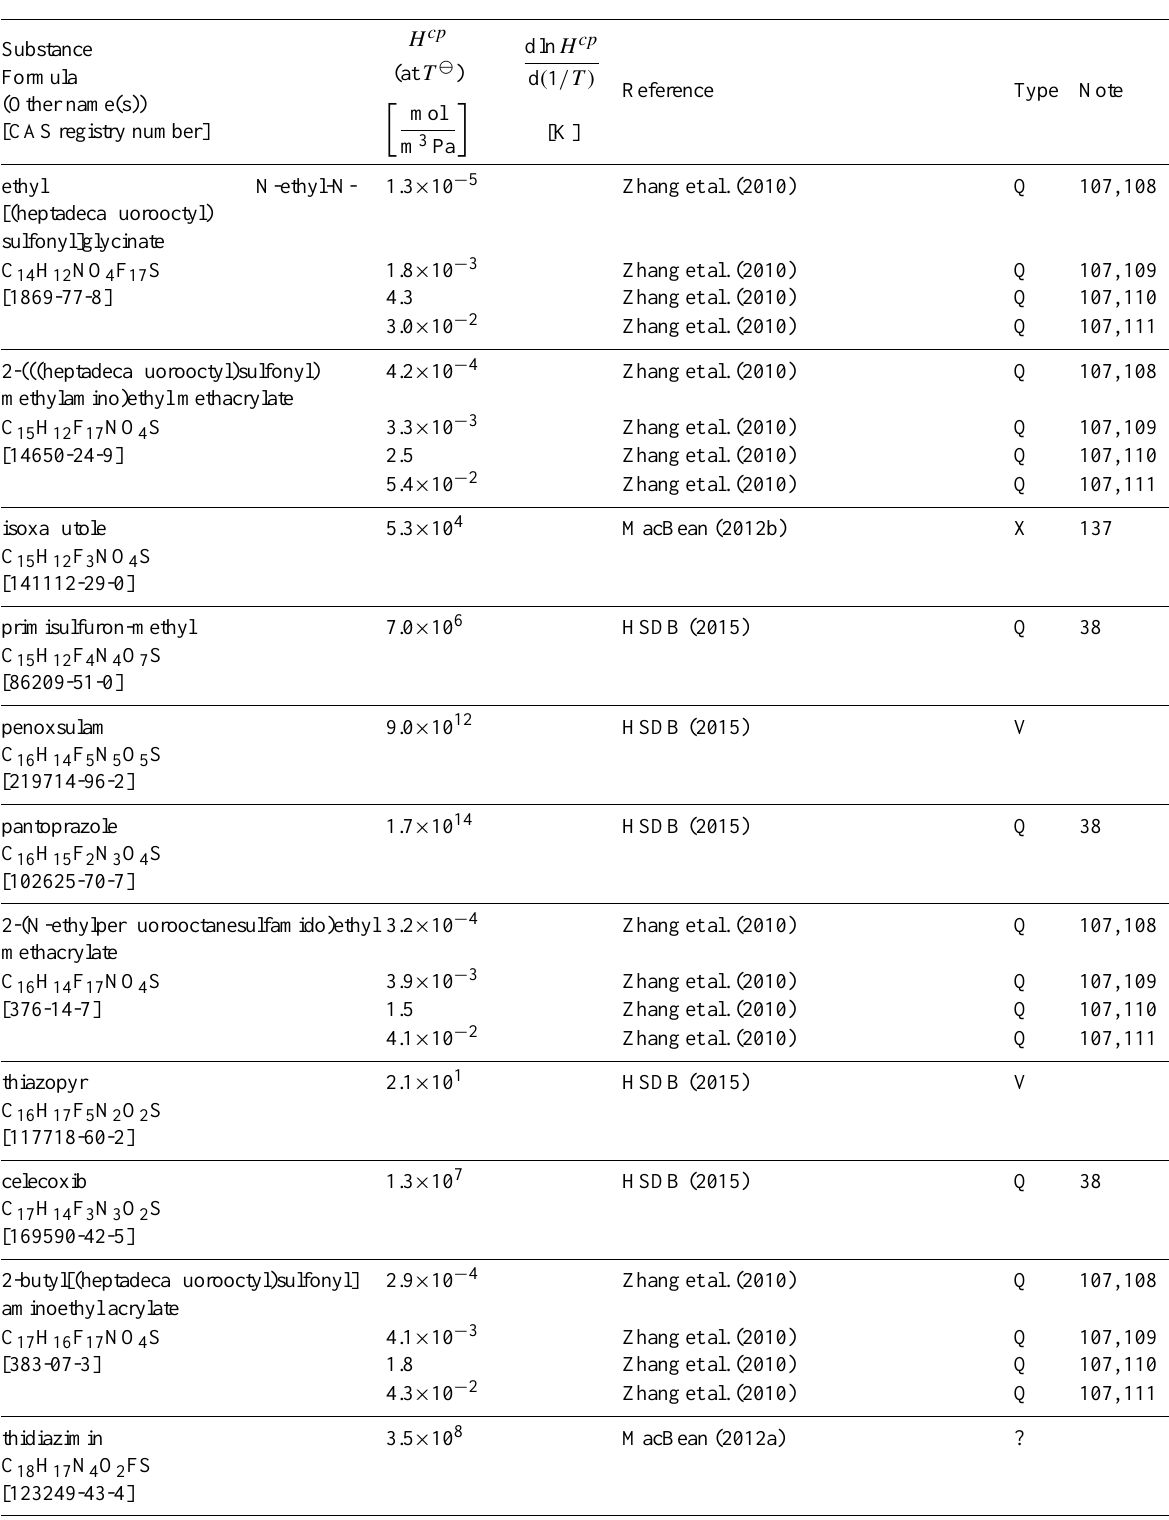
Table 6: Henry’s law constants for water as solvent